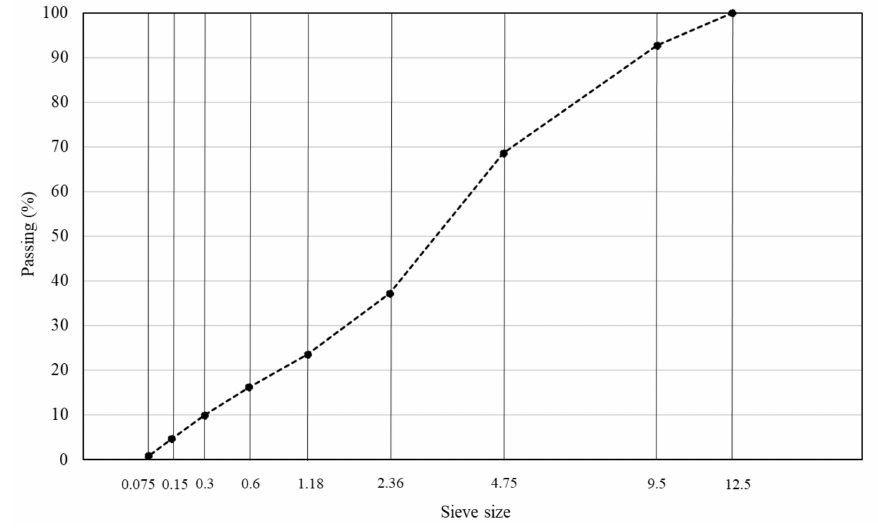
Figure 1. Waste natural materials ( a ) coconut peat and ( b ) bagasse.